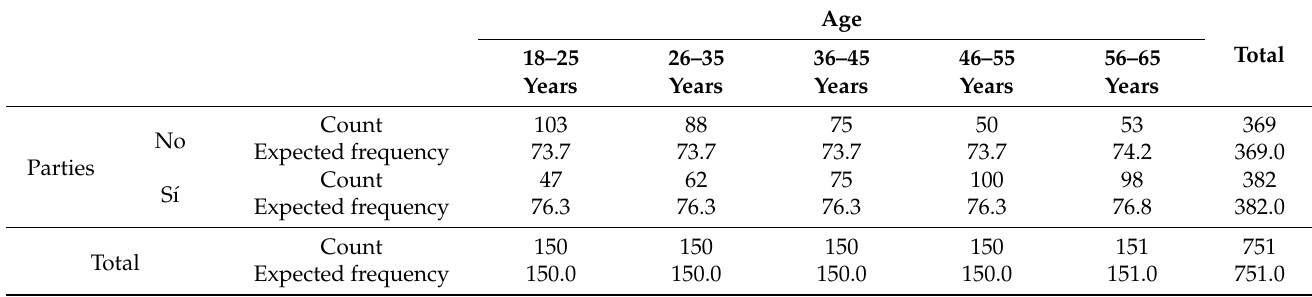
Table A3. Contingence table (Item: Age).